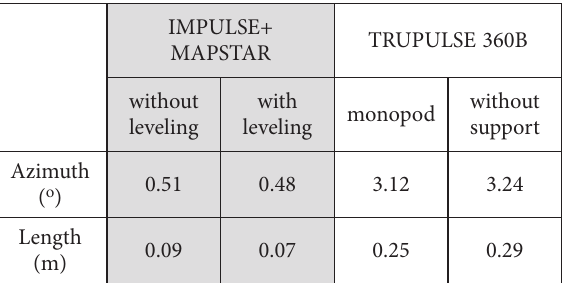
Table 3. Mean squared errors of azimuths and lengths according to measurement